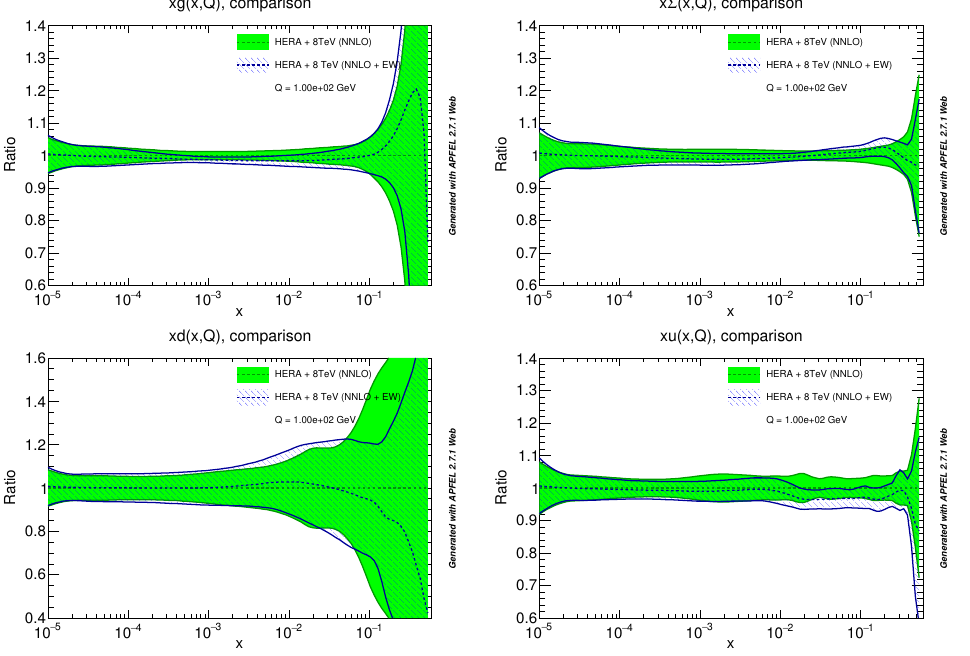
Figure 13 . Impact of the inclusion of 8 TeV p Z NNLO+EW